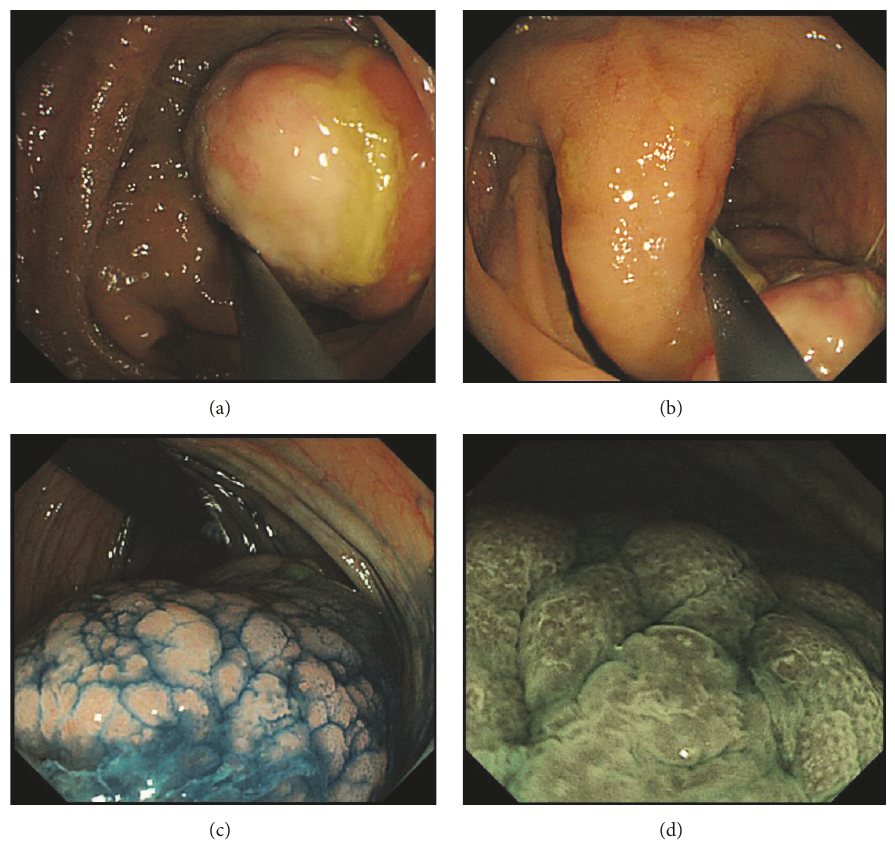
Figure 3: Endoscopic images of Case 2. The surface of the polyp head is ulcerated (a). The polyp is of pedunculated form (b). The unulcerated part of the polyp shows intact pit structure after indigo carmine spraying (c). Narrow-band imaging (d).